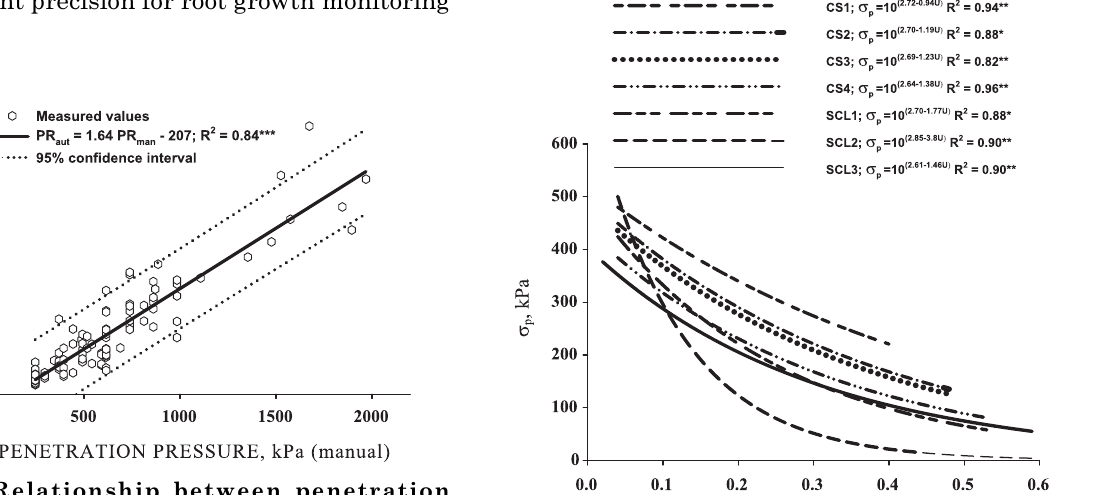
Figure 4. Relationship between penetration pressures measure manually and with automatic devices. Figure 5. Bearing capacity models for the soil